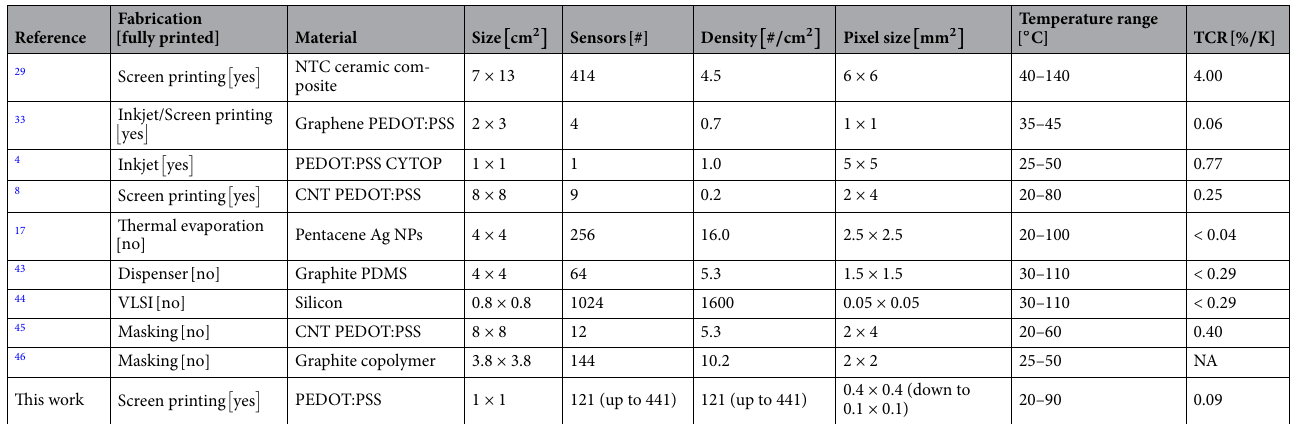
Table 2. Overview and comparison against the existing state-of the-art printed temperature sensor